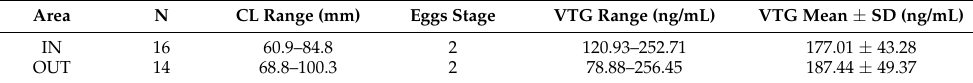
concentration range and mean estimated inside and outside FPAs.